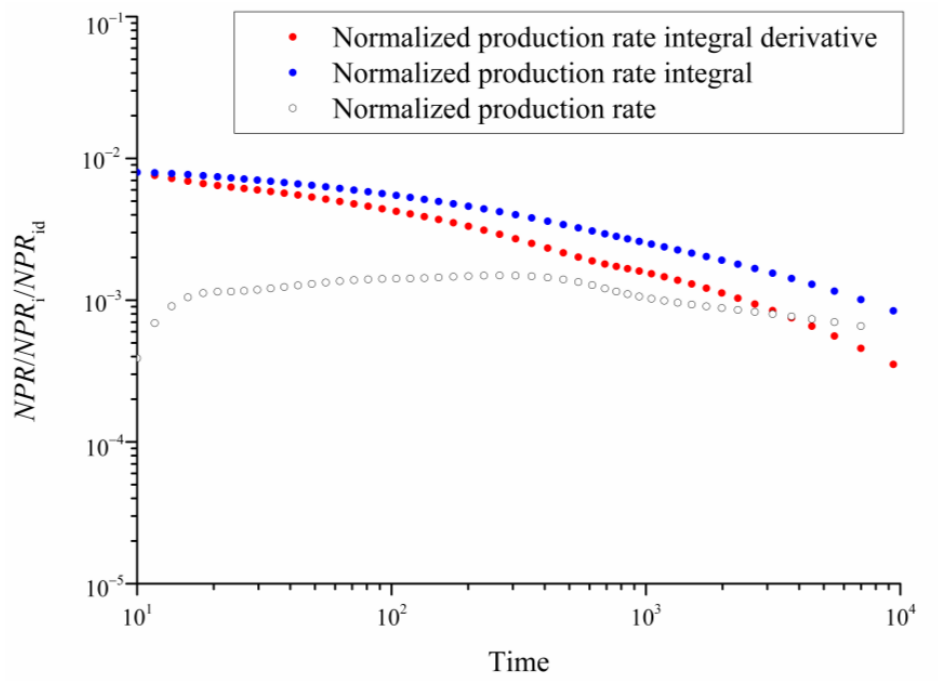
Figure 10. Blasingame production decline typical curve of the single well corresponding to flow rate deconvolution algorithm. Table 1. Comparison of prediction results between the two